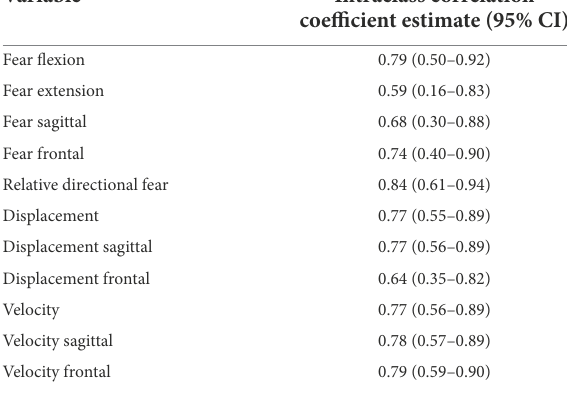
TABLE 2 Reliability estimates for directional fear questions ( n = 16) and postural sway measures ( n = 27).